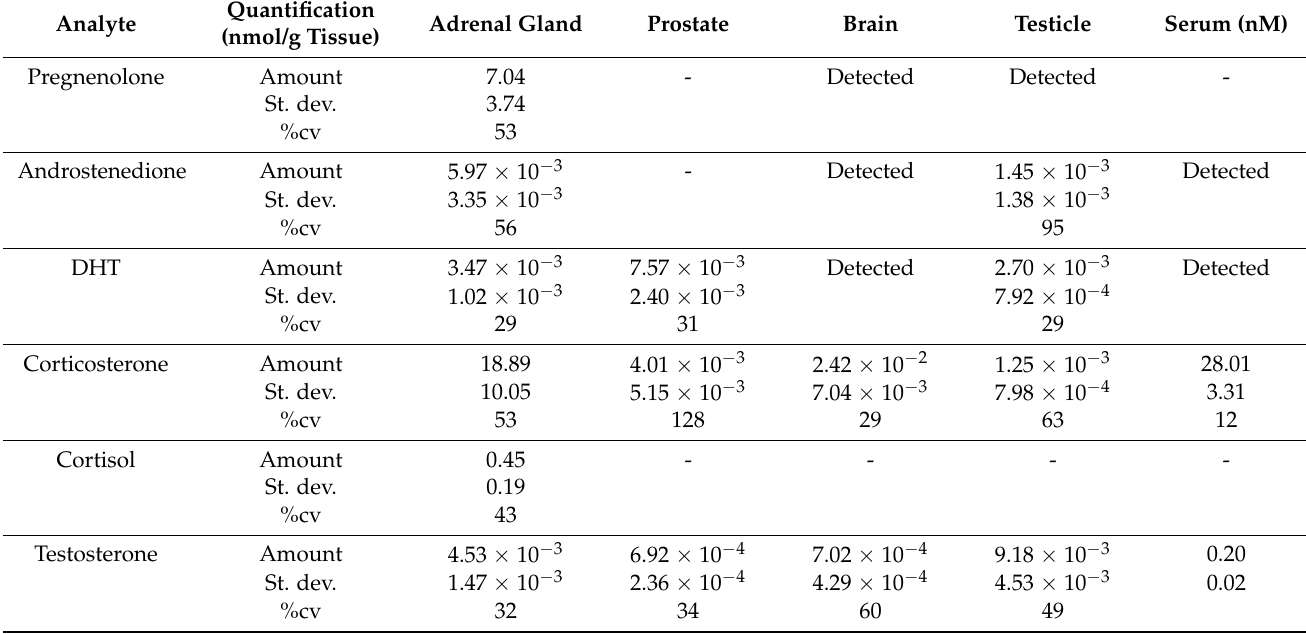
Table 3. Quantitation of three independent Wistar rat tissues: adrenal gland, prostate and brain. Adrenal glands of the same animal were titered independently, also, the prostate lobes of each rat. The averages in nmol per gram of tissue, standard deviations and coefficients of variation (%) of the three groups of samples are